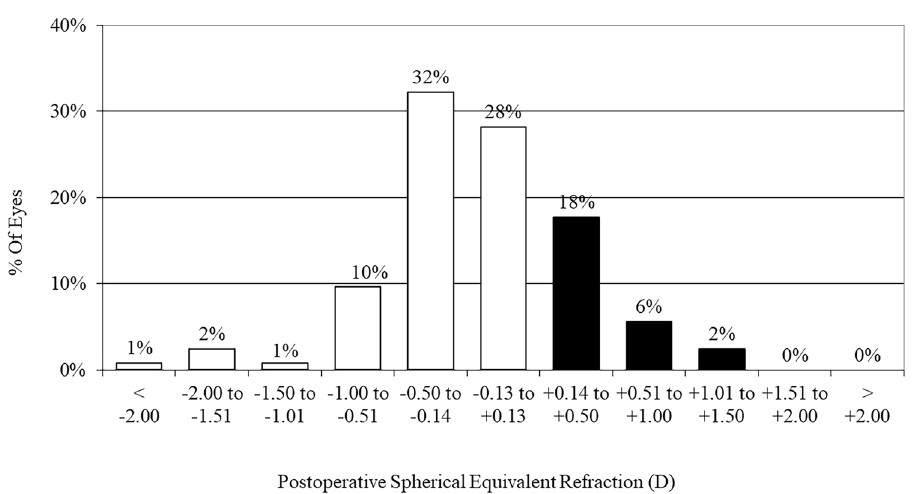
Figure 1. Percentages of eyes within ± 0.5 and ± 1.0 D of the attempted correction (spherical equivalent) after hole implantable collamer lens (ICL)